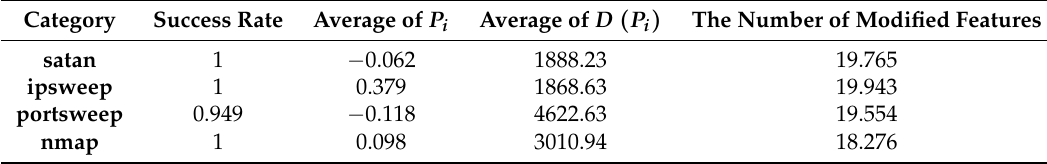
Table 7. The results of TLTD-III. The data in the table is the average of the 1000 sample test